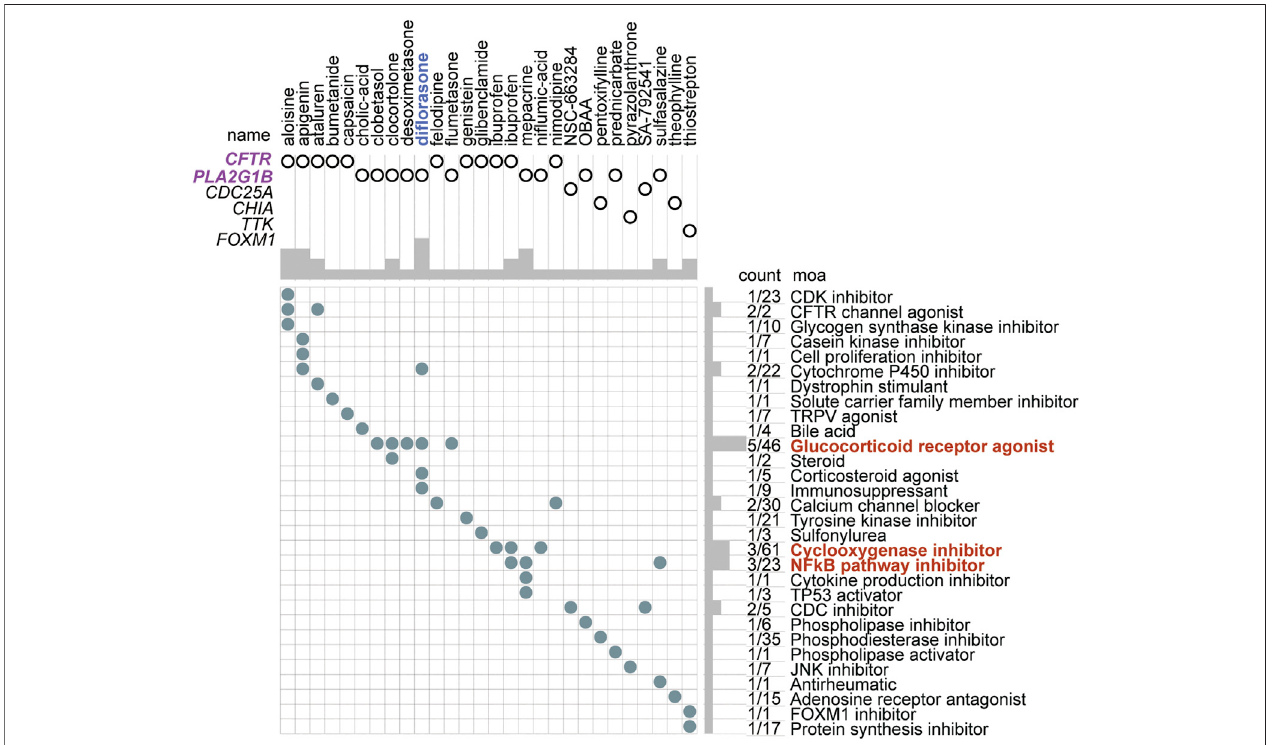
FIGURE11| Small-molecule perturbagen chemotherapeuticsforecastforhigh-riskpatients basedontheDEGs.Thechemotherapeuticsforecastforthehigh-risk patients is based on the DEGs.